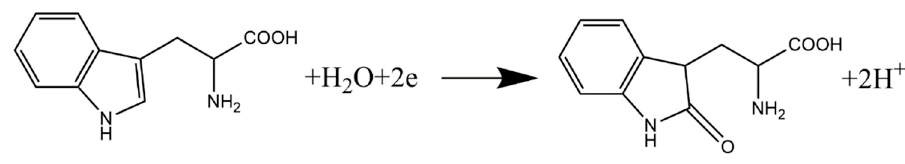
Figure 6. Effect of scanning rate ( v ) on the electrochemical responses of 10 μ M Trp. ( a ) CVs curves of 10 μ M Trp on Fe 3 O 4 /C/GCE recorded at various scanning rates ( v ); ( b ) Linear relationship between the anodic peak currents ( i pa ) and scanning rates ( v ); ( c ) Linear relationship between the anodic peak potentials ( E pa ) and Napierian logarithm of scanning rates (ln v ).